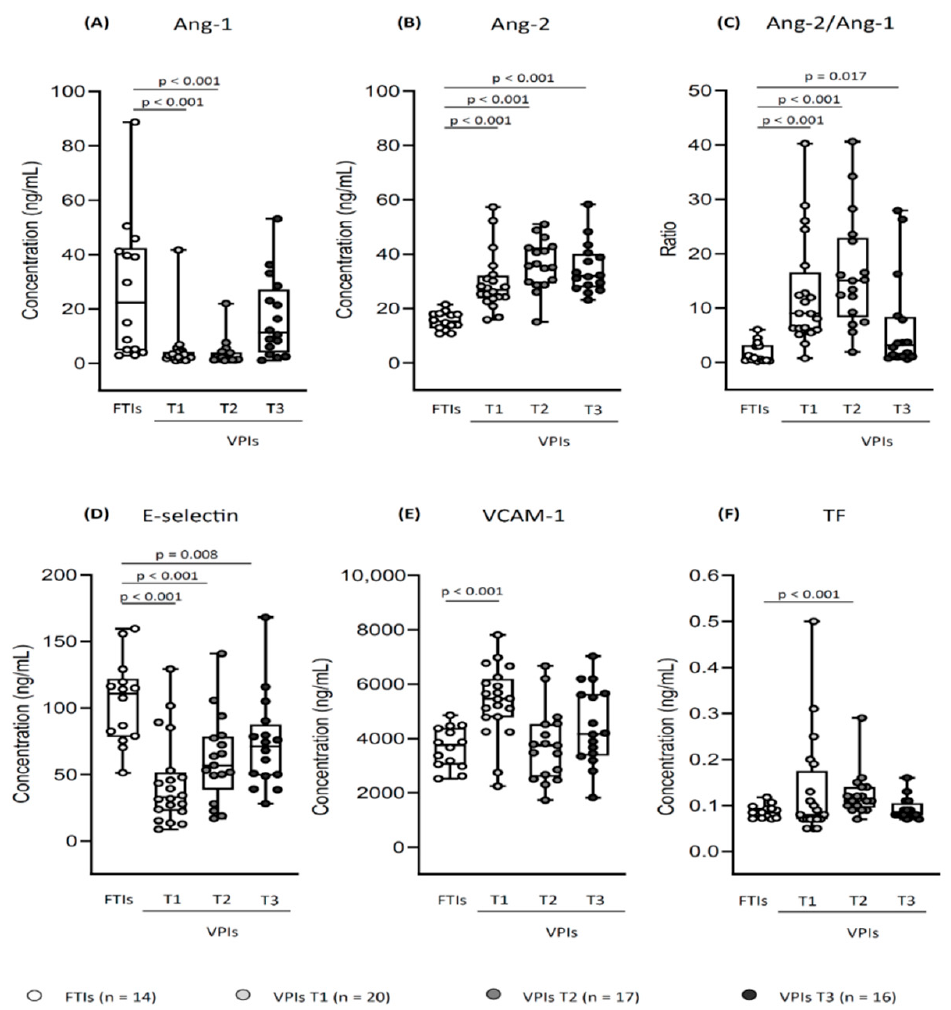
Figure 1. Soluble endothelial markers profile: relationship between very preterm infants (VPIs) at T1,